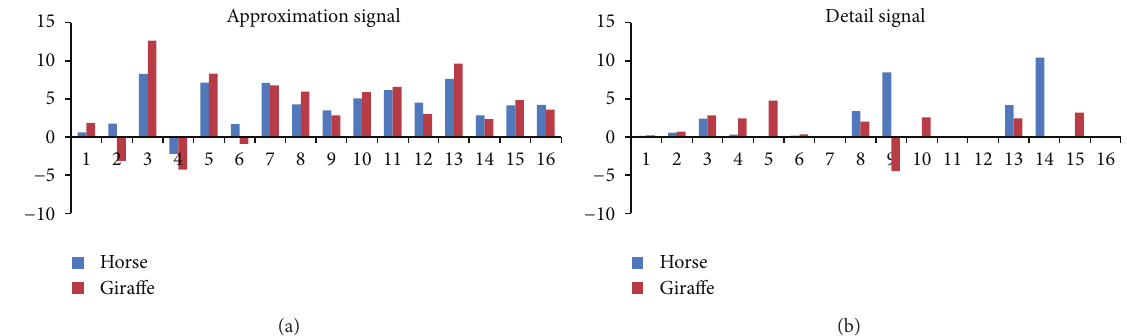
Figure 12: The first 16HWD of the approximation and detail signal for “Horse” and “Giraffe”.